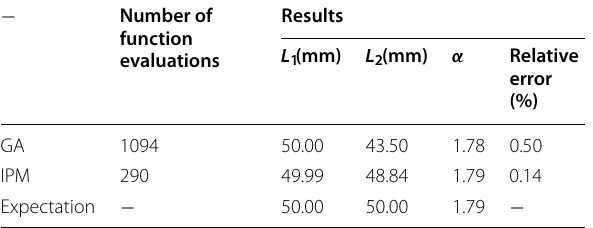
Table 2 Comparison of the results obtained by GA and IPM −